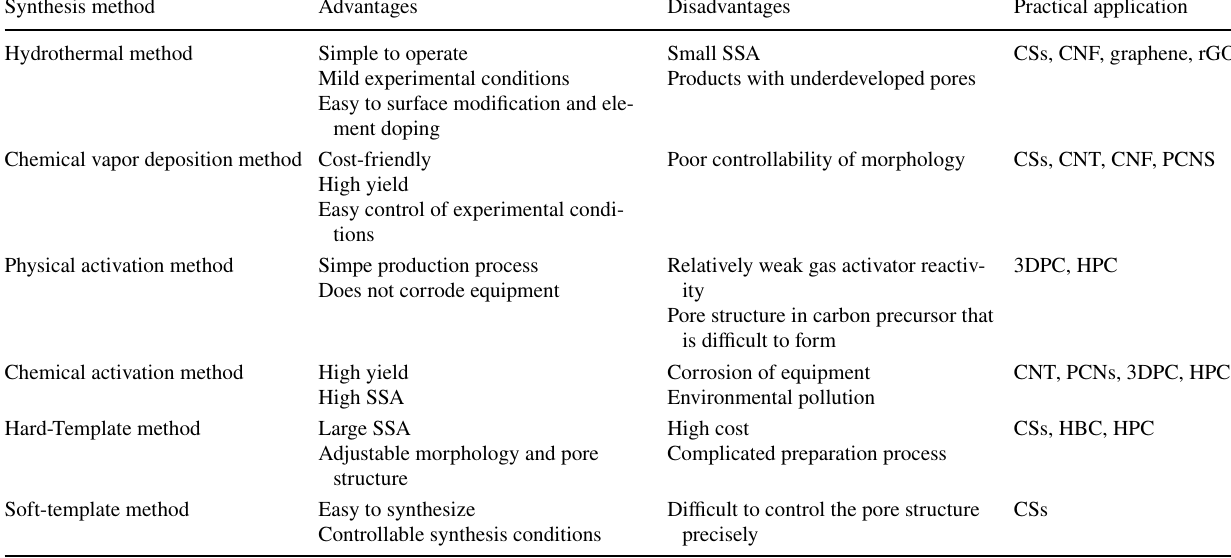
Table 2 A summary of Advantages and disadvantages of synthesis methods for carbons Synthesis